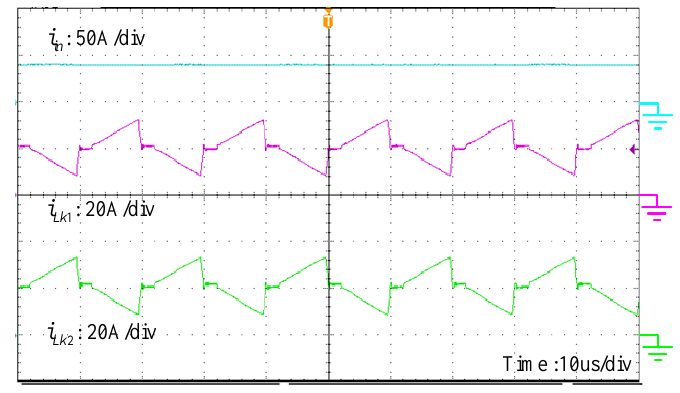
Figure 11. Measured waveforms of the voltages on the clamp capacitors.